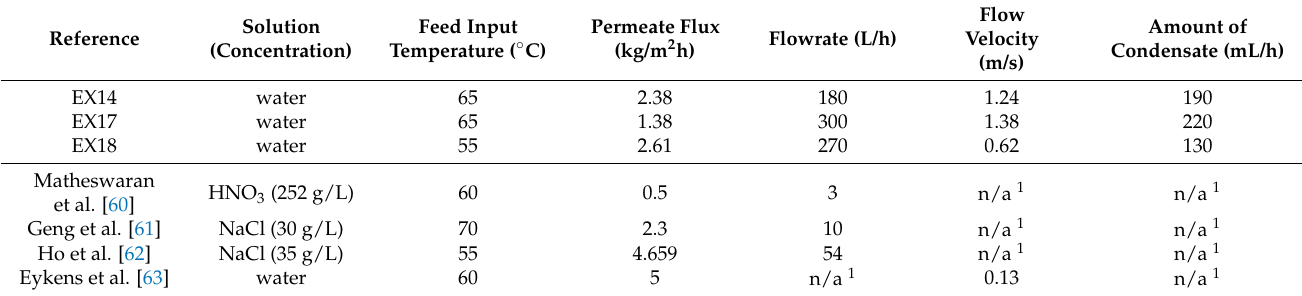
Table 12. Comparison of experiments EX14, EX17, and EX18 with other published